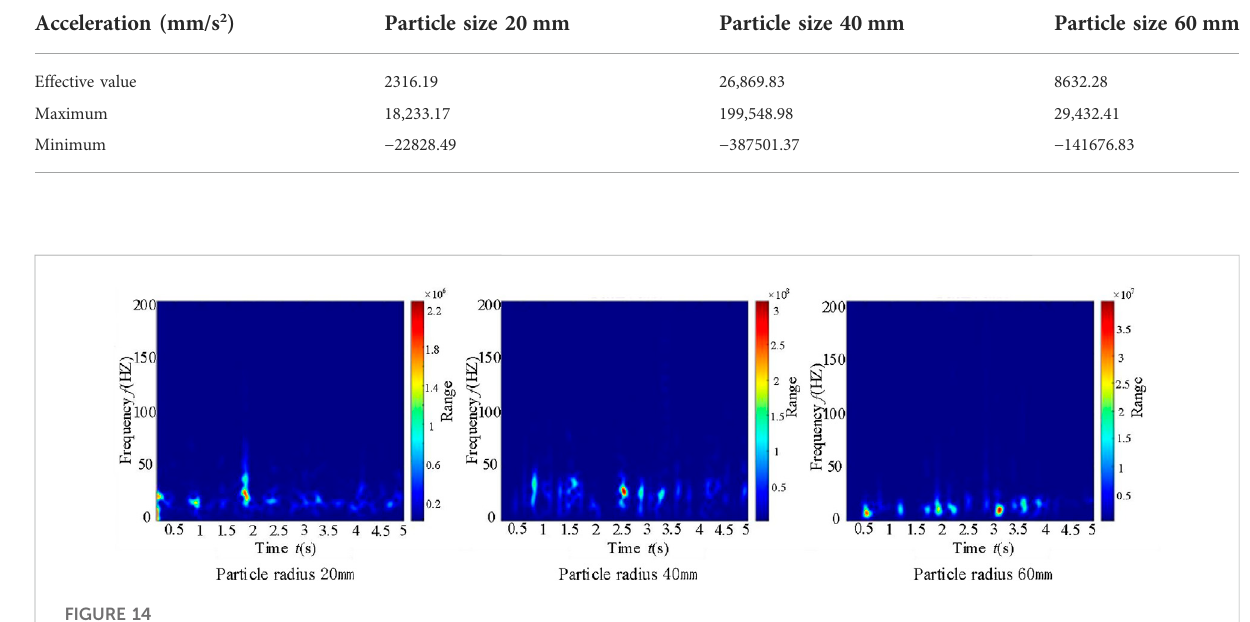
TABLE 3 Acceleration values at different particle sizes.